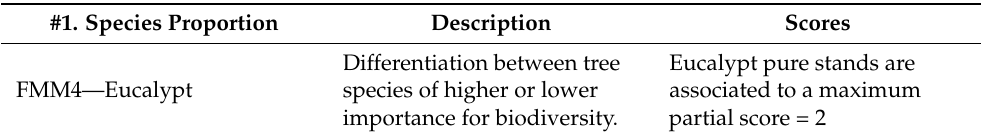
Table 4. Species proportion, description, minimum and maximum values used to define the FMM4 biodiversity score.